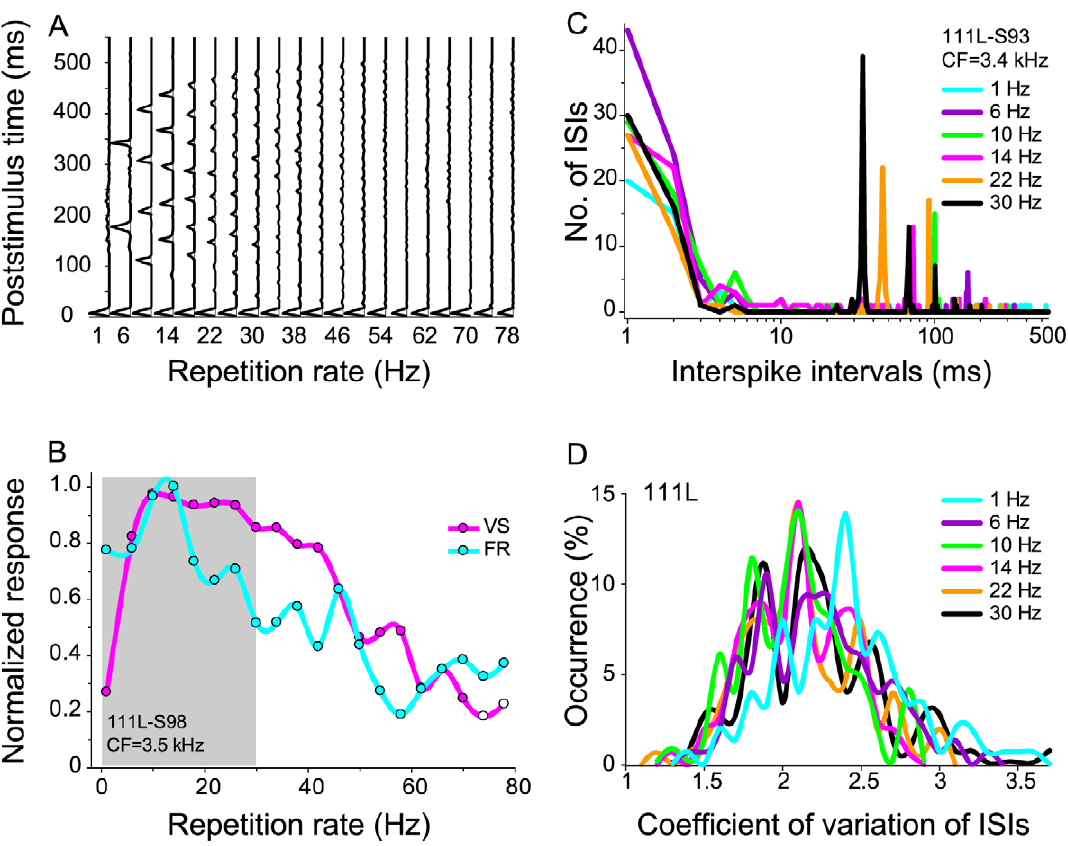
Figure 1. Repetition rate transfer functions for VS and FR. (A) Poststimulus time histograms for 20 repetition rates for an AAF site. Response strength was normalized to the maximum response at 1 Hz. Maximum height of the FR ordinate: 15 spikes. Information values for 111L-S98: VS info: 0.62 bits/stimulus; FR info: 0.23 bits/stimulus; ISI (1 ms) info: 0.51 bits/stimulus; ISI (10 ms) info: 1.95 bits/stimulus. (B) Corresponding RRTFs for VS (magenta line) and FR (blue line). Data points are fit by a polynomial cubic spline. Filled circles are significant VS values (Rayleigh test, p , 0.001). Gray background illustrates the repetition rate range at the focus in this study. (C) ISI histogram for 6 repetition rates. Multiple ISI peaks correspond to integer multiples of stimulus periods. Information values for 111L-S93: VS info: 0.09 bits/stimulus; FR info: 0.11 bits/stimulus; ISI (1 ms) info: 1.20 bits/ stimulus; ISI (10 ms): 2.28 bits/stimulus. (D) Population distribution of the coefficient of variation (CV) of ISIs for hemisphere 111L ( n =130). CV of ISI that estimates the variability of ISIs was computed by dividing the standard deviation of ISIs by the mean. Histograms of CV distributions, smoothed by a polynomial cubic spline, are illustrated for six different repetition-rates.